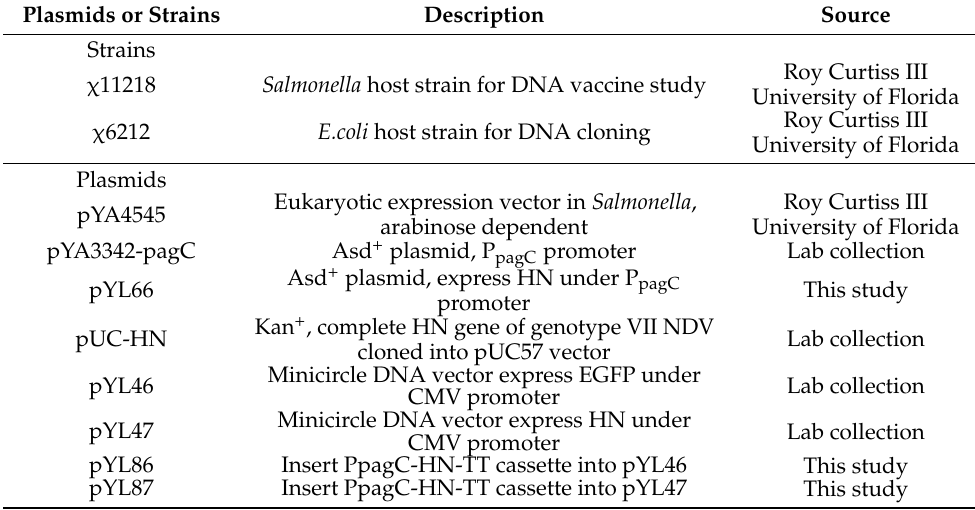
Table 1. Bacterial strains and plasmids used in this study.